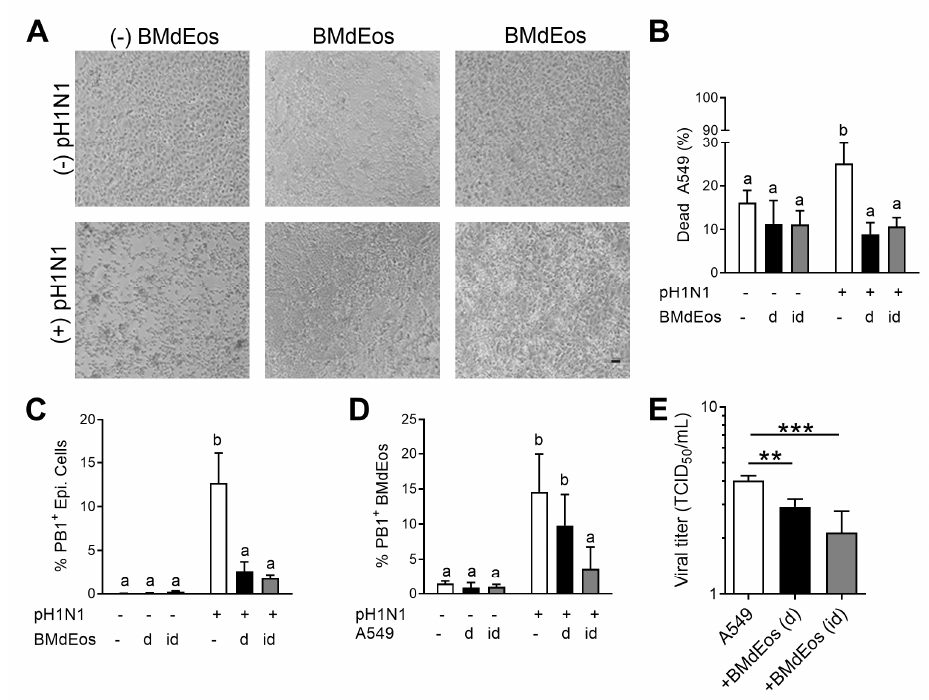
Figure 4. Eosinophils protect the epithelial cell barrier during influenza virus infection. ( A ) Representative images of A549 cell monolayers in each culture condition. ( B ) Percentage of dead A549 cells in the culture conditions. ( C ) Influenza internal protein (PB1) expressing A549 cells and ( D ) bone marrow-derived eosinophils in each culture condition. ( E ) Influenza A virus (pH1N1) titer in the supernatants. Experiments independently repeated three times for rigor and reproducibility. Data are represented as the mean and standard deviation of n = 5–6 samples analyzed by two-way ANOVA with Sidak’s multiple comparisons test. Differences are significant ( p < 0.05) when letters above bars are dissimilar. ** p < 0.01 and *** p < 0.001. BMdEos—bone marrow-derived eosinophils; d/D—direct contact; id/ID—indirect